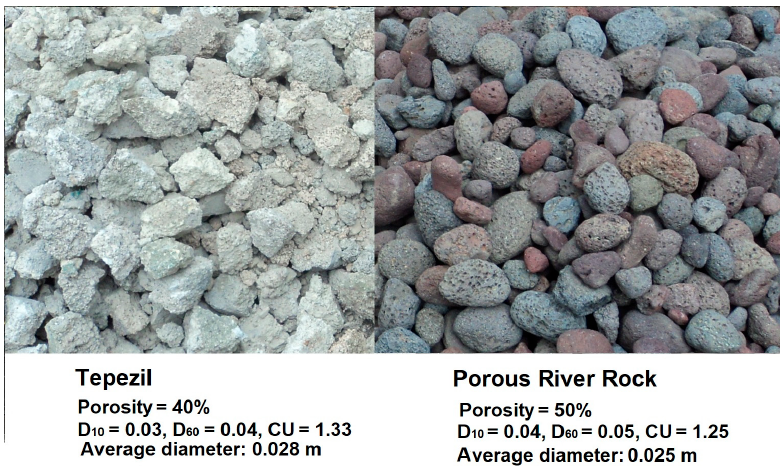
Figure 1. Schematic of the mesocosms wetland study.